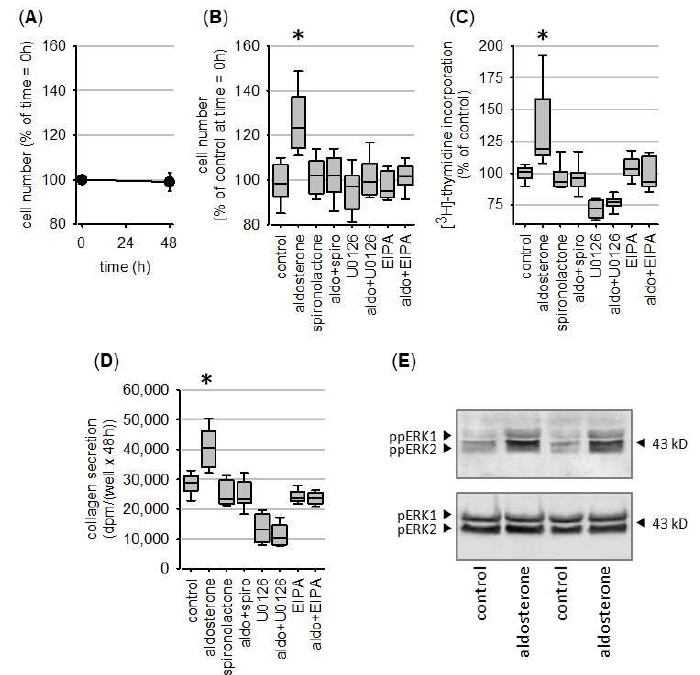
Figure 3. ( A ) Cell number is stable over a 48h period in minus media. ( B , C ) Aldosterone (aldo, 10 nmol/L) induced proliferation of GMC proliferation is prevented by inhibition of Na + /H + -exchange (EIPA), by inhibition of ERK1/2- phosphorylation (U0126) and by blockade of the mineralocorticoid receptor (spiro). N = 10. * = p < 0.05 versus respective control. ( D ) Aldosterone (aldo, 10 nmol/L) induced proliferation collagen secretion is prevented by inhibition of Na + /H + - exchange (EIPA), by inhibition of ERK1/2-phosphorylation (U0126) and by blockade of the mineralocorticoid receptor (spiro). N = 8. * = p < 0.05 versus respective control. ( E ) Aldosterone (10 nmol/L, 15 min) enhances ERK1/2 phosphorylation